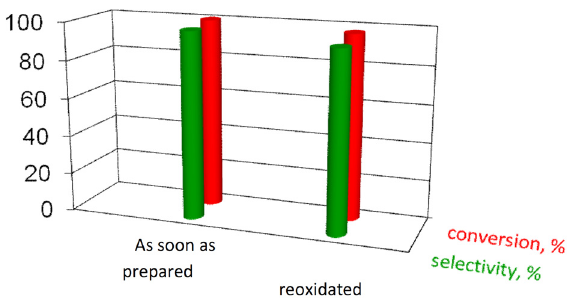
Figure 7. Comparison of activity data of the 1.5AuSZ2